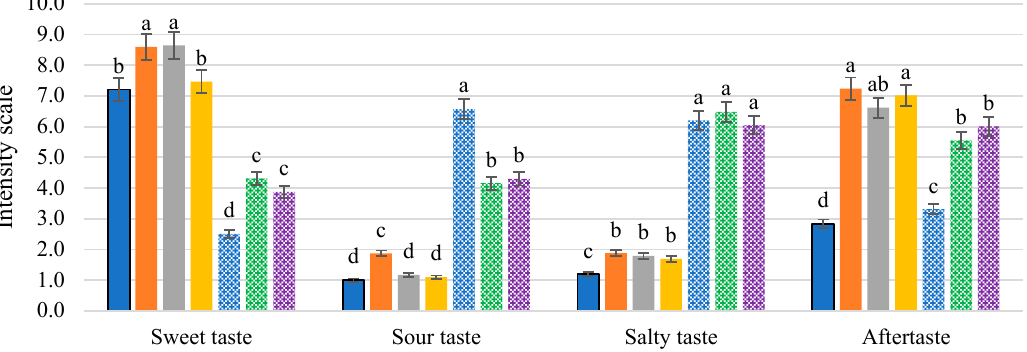
Figure 2. The sensory properties of hydrolysed permeate samples after first-stage fermentation. Using sweet whey permeate and enzyme 1GYS—GODO-YNL2; 1NFS—NOLA™ Fit5500; 1HLS—Ha-Lactase 5200. Using acid whey permeate and enzyme 2GYA—GODO-YNL2; 2NFA—NOLA™ Fit5500; 2HLA—Ha-Lactase 5200. Control—commercial glucose-galactose syrup. The values